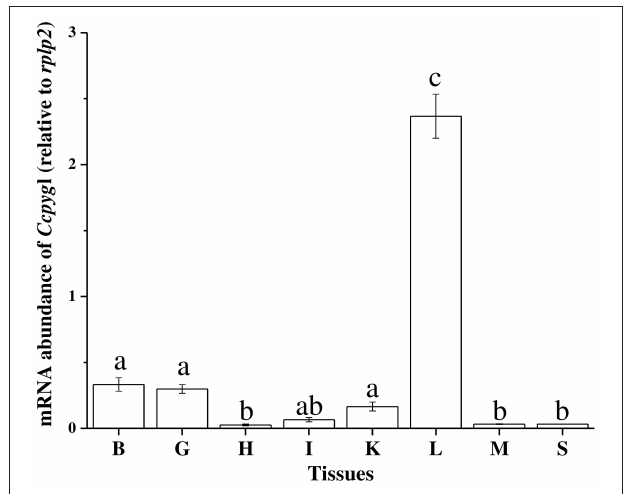
FIGURE 3 | Tissue distribution of Ccpygl ( Chanos chanos liver isoform of glycogen phosphorylase) mRNA expression of the milkfish detected by qPCR. Values are means ± SEM, n = 3. B, brain; G, gill; H, heart; I, intestine; K, kidney; L, liver; M, muscle; S,